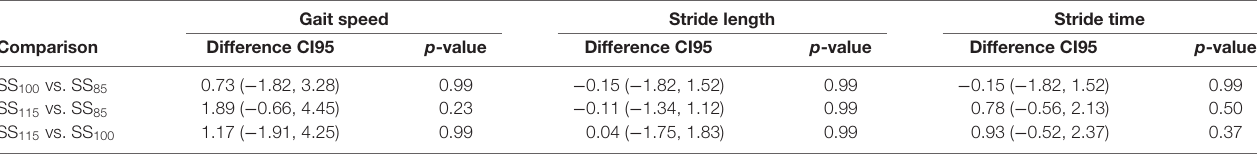
TABLE 3 | Difference in coefficient of variation between target walking speeds with visual